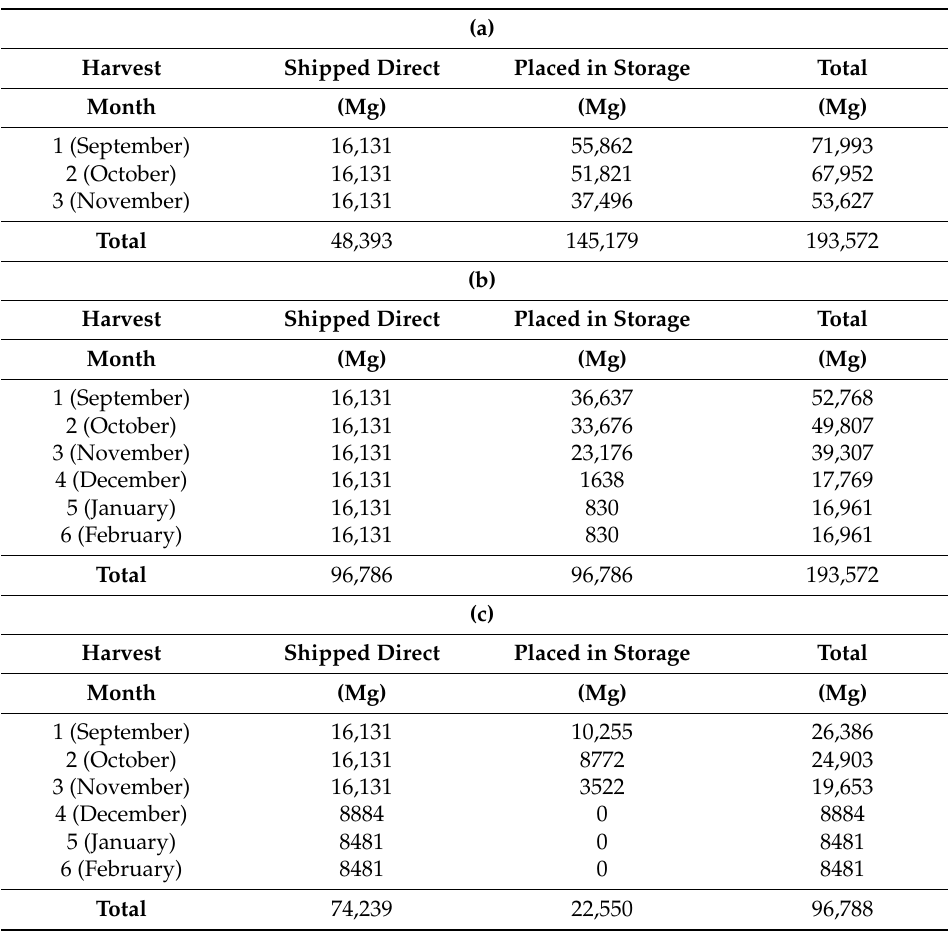
Table 4. ( a ) Biomass harvested, delivered direct, and placed in storage (Scenario 1) (results obtained with Scenario 1 MATLAB program). ( b ) Biomass harvested, delivered direct, and placed in storage, storage (Scenario 2) (results obtained with Scenario 2 MATLAB program). ( c ) Biomass harvested, delivered direct, and placed in storage, storage (Scenario 3) (results obtained with Scenario 3 MATLAB